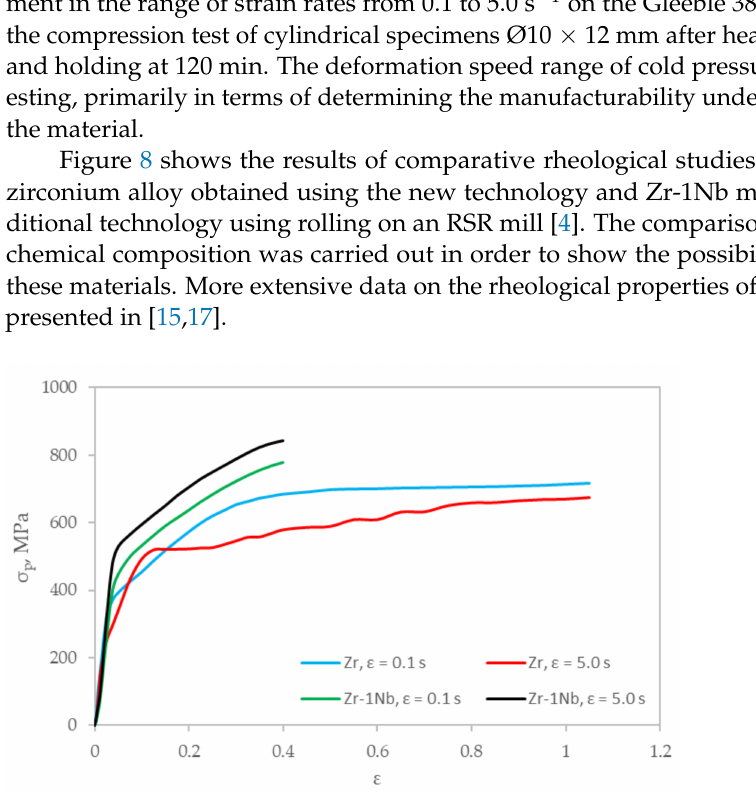
Figure 8. Influence of strain rate and strain level on change in deformation resistance (uniaxial compression method on Gleeble 3800 plastometer) of specimens Ø10 × 12 mm manufacture from Zr-1Nb alloy (traditional route) and zirconium (spark plasma